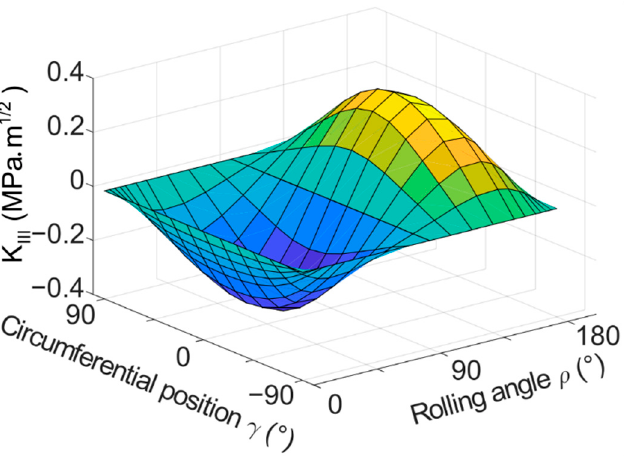
Figure 8. 3D plot of K III as a function of both, the circumferential position on the crack front γ and the rolling orientation of the crack ρ , crack length a = 1.25 mm.